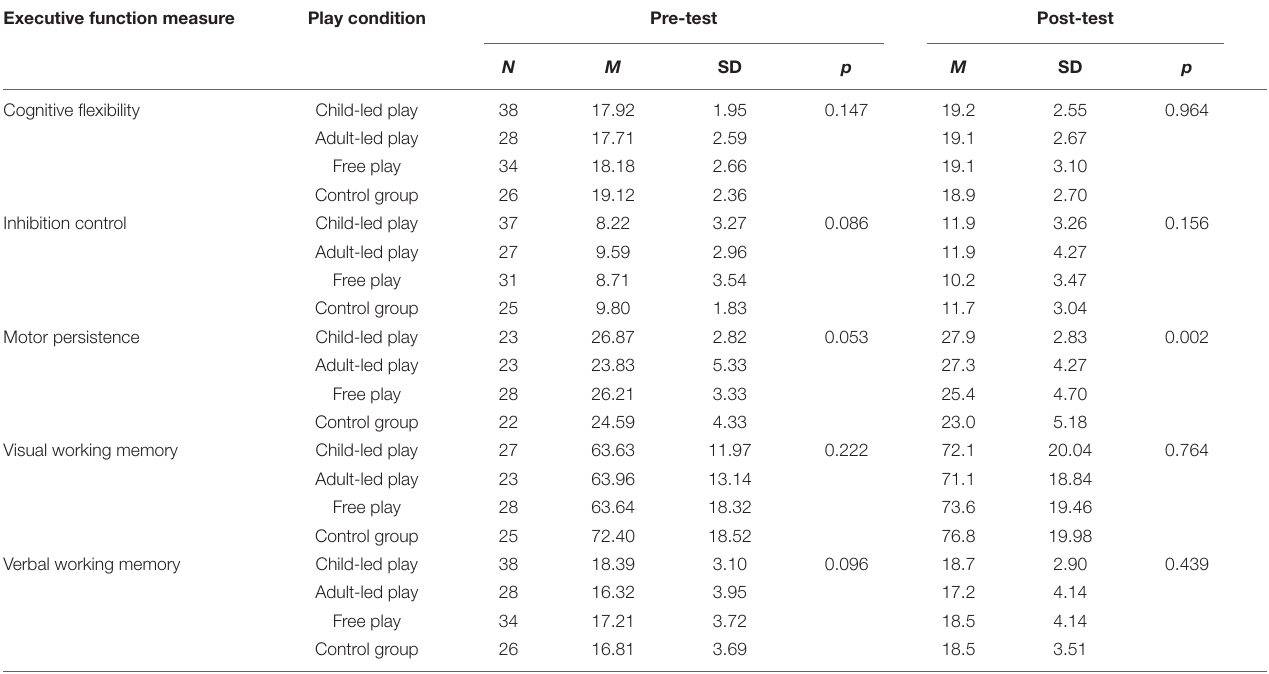
TABLE 1 | Descriptive statistics for pre- and post-test children’s performance in executive function tasks for each of the four conditions. Executive function